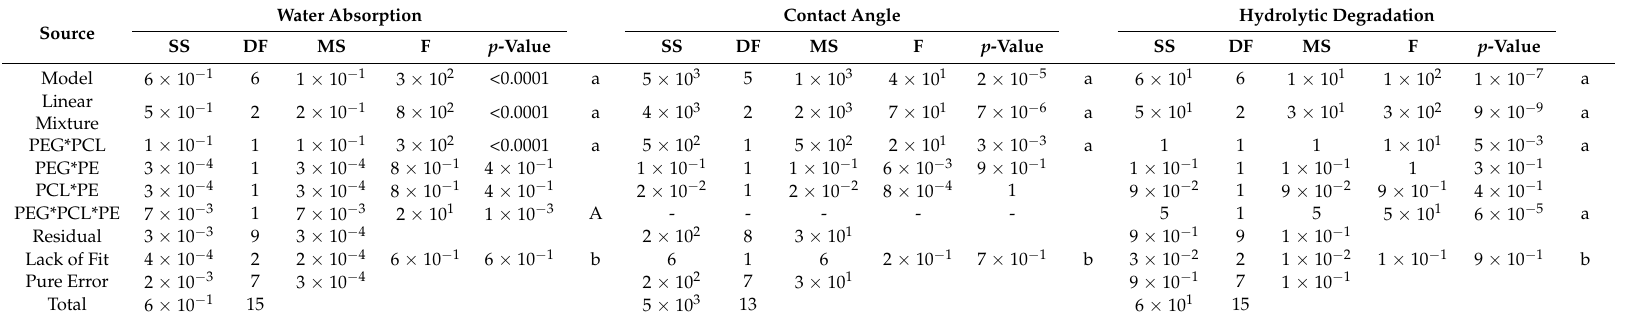
Table 2. ANOVA test of model regression for water absorption, contact angle and hydrolytic degradation.